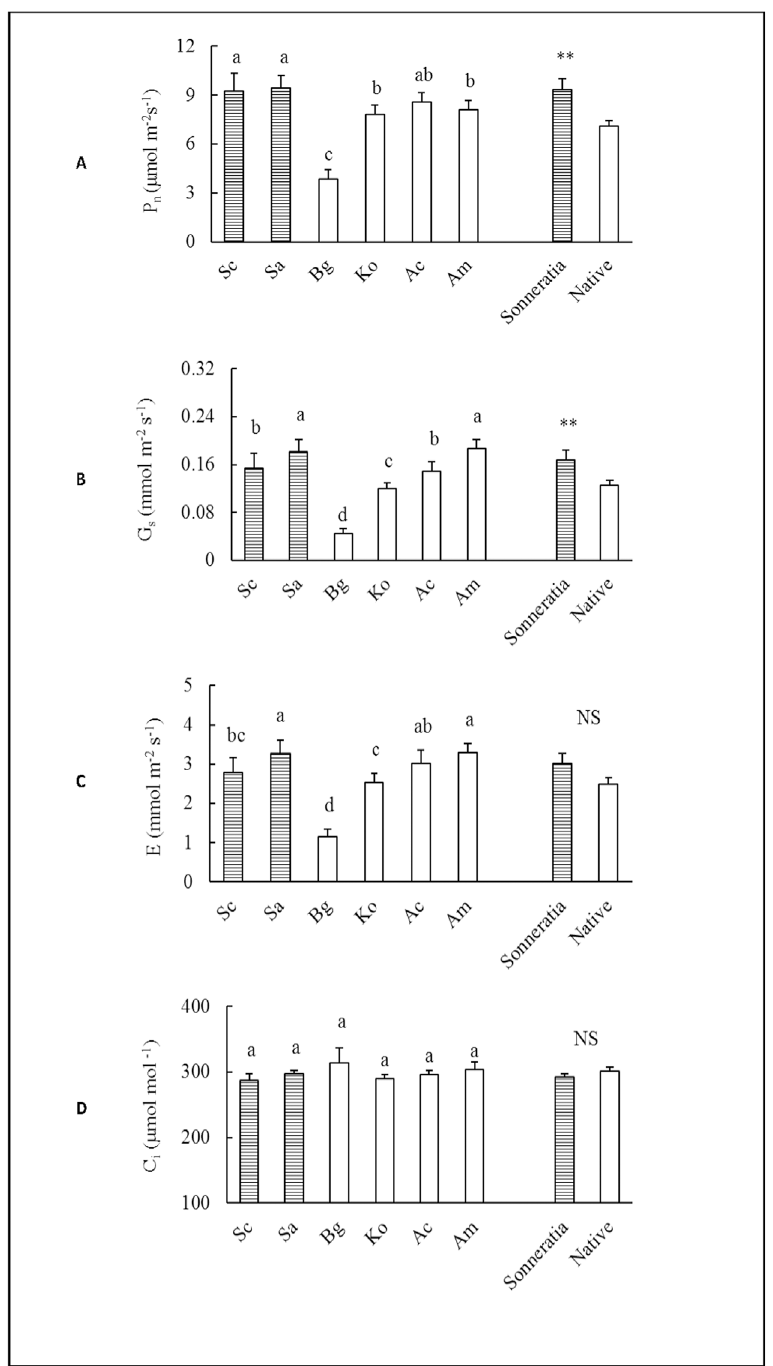
Fig 1. Comparisons of the annual average (A) net photosynthetic rate (P n ), (B) stomatal conductance (G s ), (C) rate of transpiration (E) and (D) intercellular CO 2 concentration (C i ) between alien Sonneratia and native mangrove species. Fig 1 legend: Error bars represent 1 SE. Different letters indicate significant differences at p (cid:6) 0.05 among the six species according to two-way ANOVA; ** indicates a significant difference between alien Sonneratia species and native mangroves at p (cid:6) 0.01, NS indicates not significant at p (cid:6) 0.05 according to the independent samples